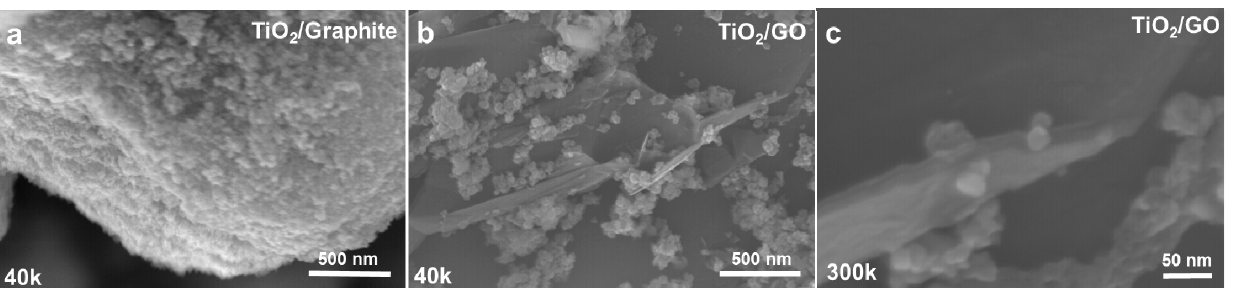
Figure 7. SEM images at a magnification of 40 k for ( a ) TiO 2 /graphite and ( b ) TiO 2 /GO, and at a magnification of 300 k for ( c ) TiO 2 /GO (c. Reprinted with permission from [10] Copyright 2022 John Wiley & Sons, Inc.).